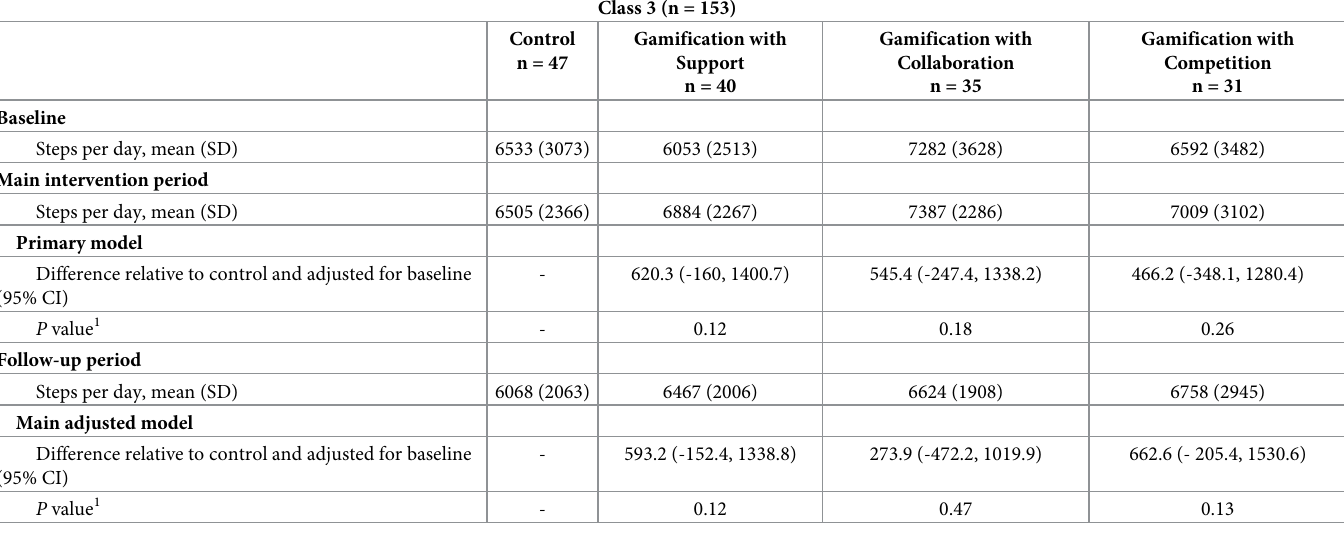
Table 5. Adjusted model of change in mean daily step count by intervention arm for class 3 (less motivated and